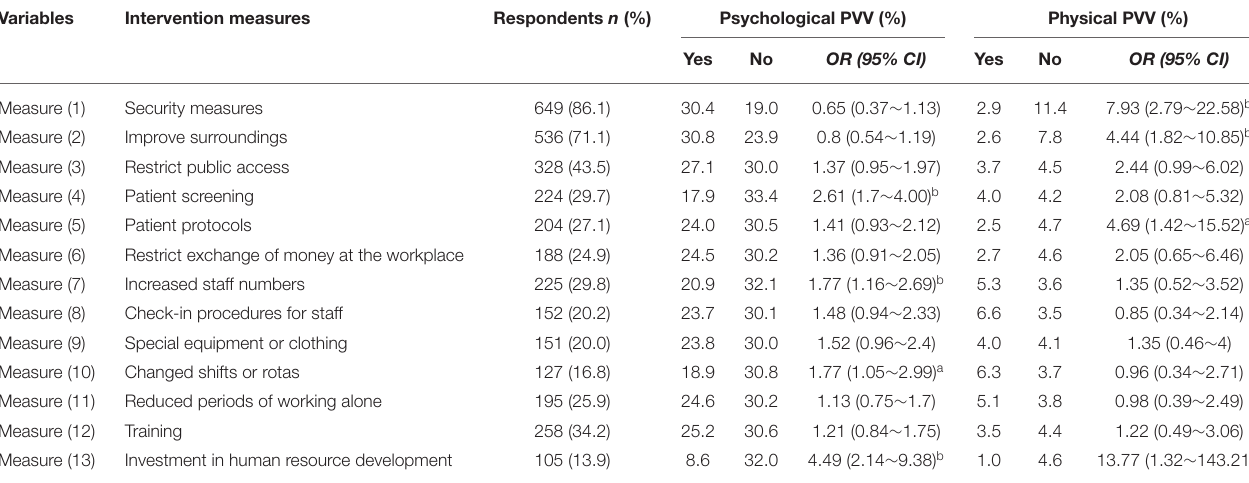
TABLE 4 | The correlation between 13 measures against violence and PVV.